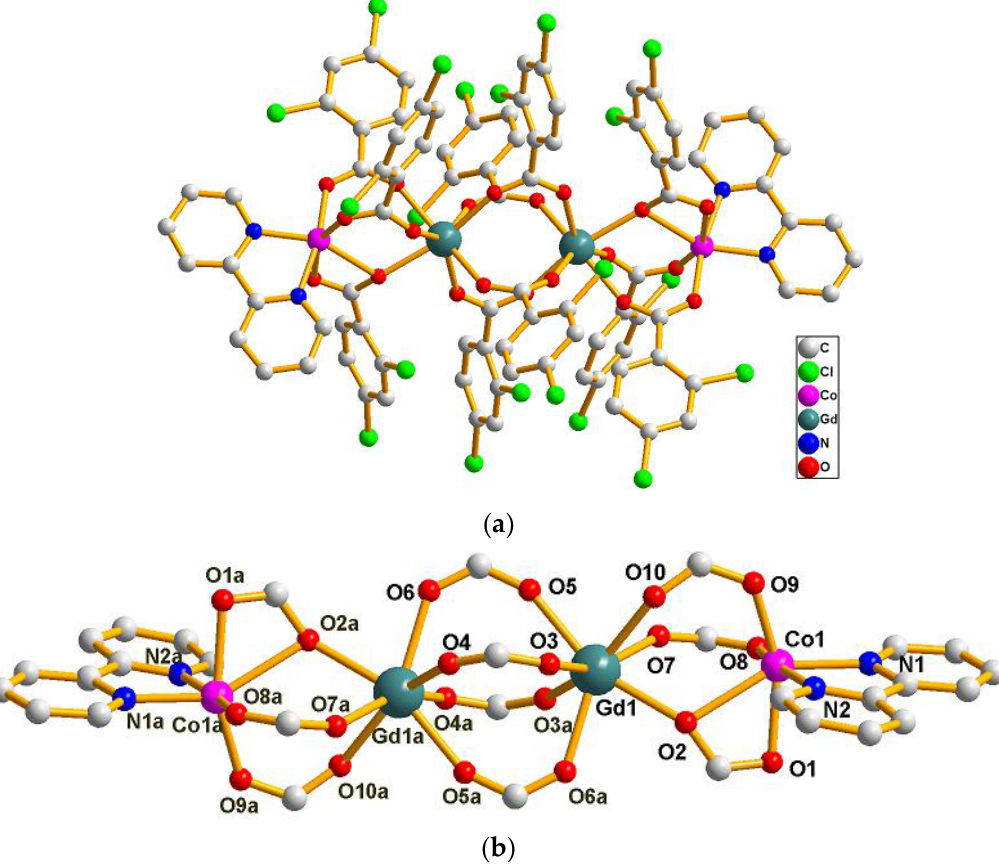
Figure 3. ( a ) The molecule structure of the tetranuclear [Gd 2 Co 2 (L2) 10 (bipy) 2 ] of 8 . Hydrogen atoms are omitted for clarity. ( b ) The coordination environments of the metal centers in 8 .